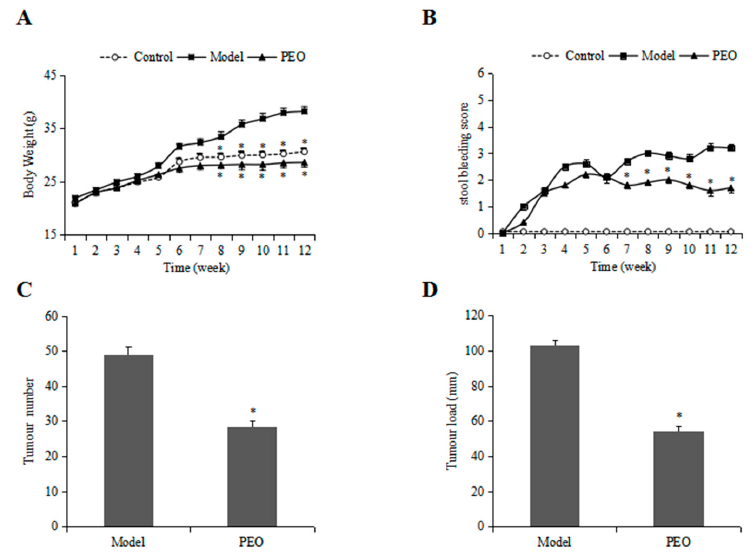
Figure 1. The effects of PEO on mouse body weight changes is shown in ( A ); The PEO attenuated stool bleeding score in Apc Min/+ mice ( B ); PEO treatment reduced tumor counts ( C ) and tumor load ( D ) in Apc Min/+ mice. (Data represent the means ± SE of independent experiments. * p < 0.05 relative to model group).